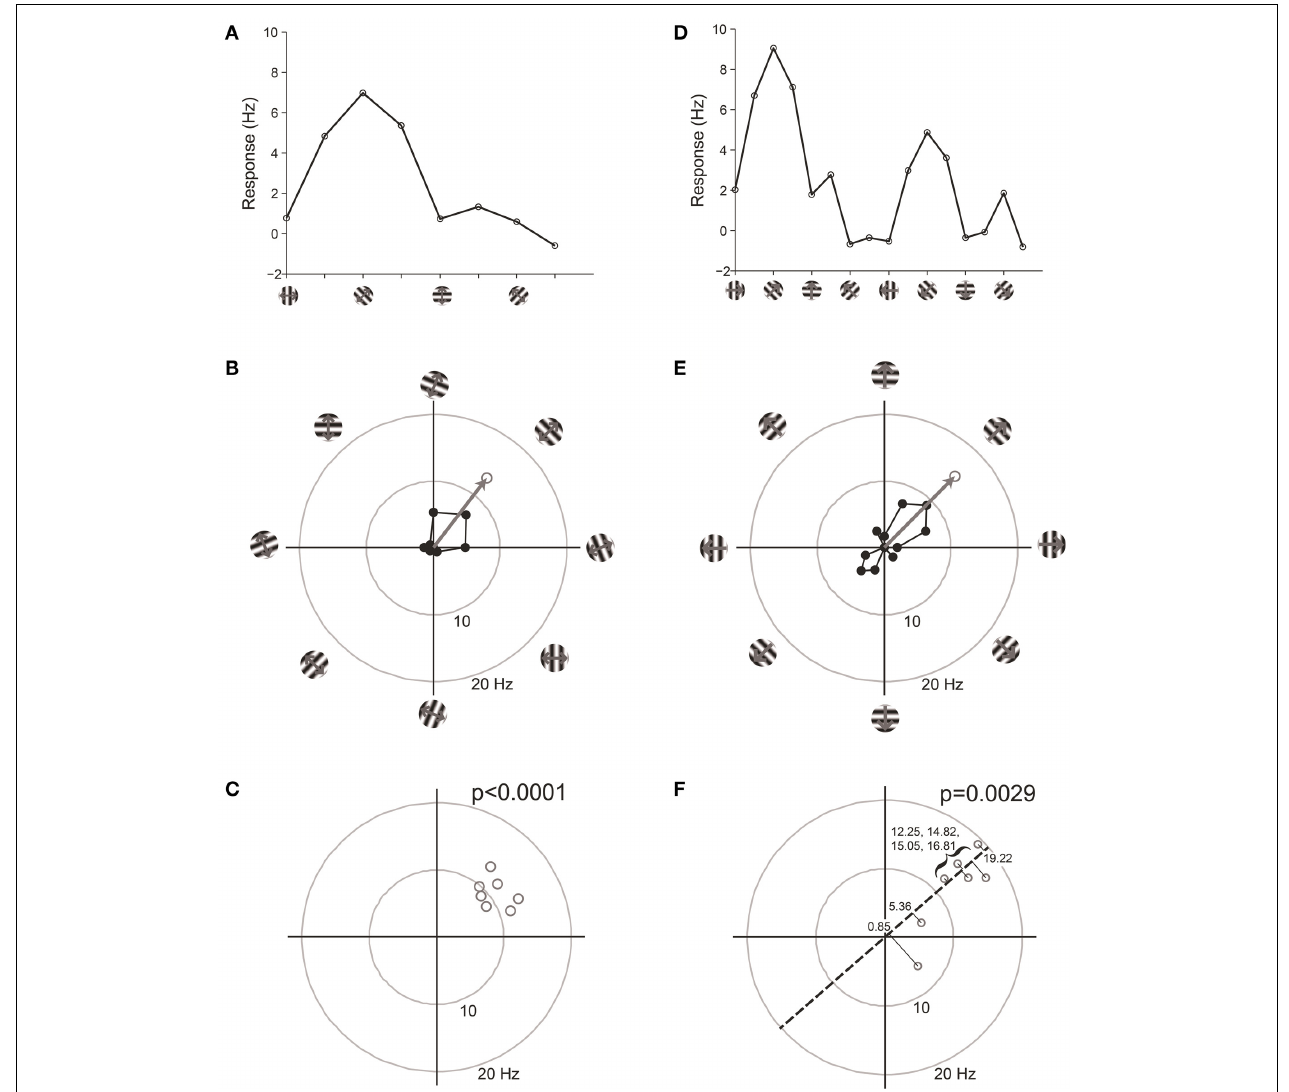
FIGURE 7 | Vector-based statistical tests with orientation (A–C) and direction (D–F) responses. This figure uses data from a model cell with strong tuning: Underlying OI = 0 . 9, DI = 0 . 5, noise = 20%. 16 directions (22.5 ◦ steps) were tested. For the orientation analysis, opposite directions at the same orientation were averaged together. (A) One trial from the model cell plotted in orientation response. Note that a “trial” is defined here as one measurement at each stimulus orientation. (B) The response from the trial shown in (A) , plotted in polar coordinates. Black: The response obtained at individual orientations. Gray: The vector sum of the responses at individual orientations. This is the “orientation vector” on this trial. (C) Orientation vectors from seven trials from the model cell. Gray circles show the orientation vectors from the seven trials. The p -value above the graph gives the result of Hotelling’s T 2 -test, which tests for whether the 2-dimensional